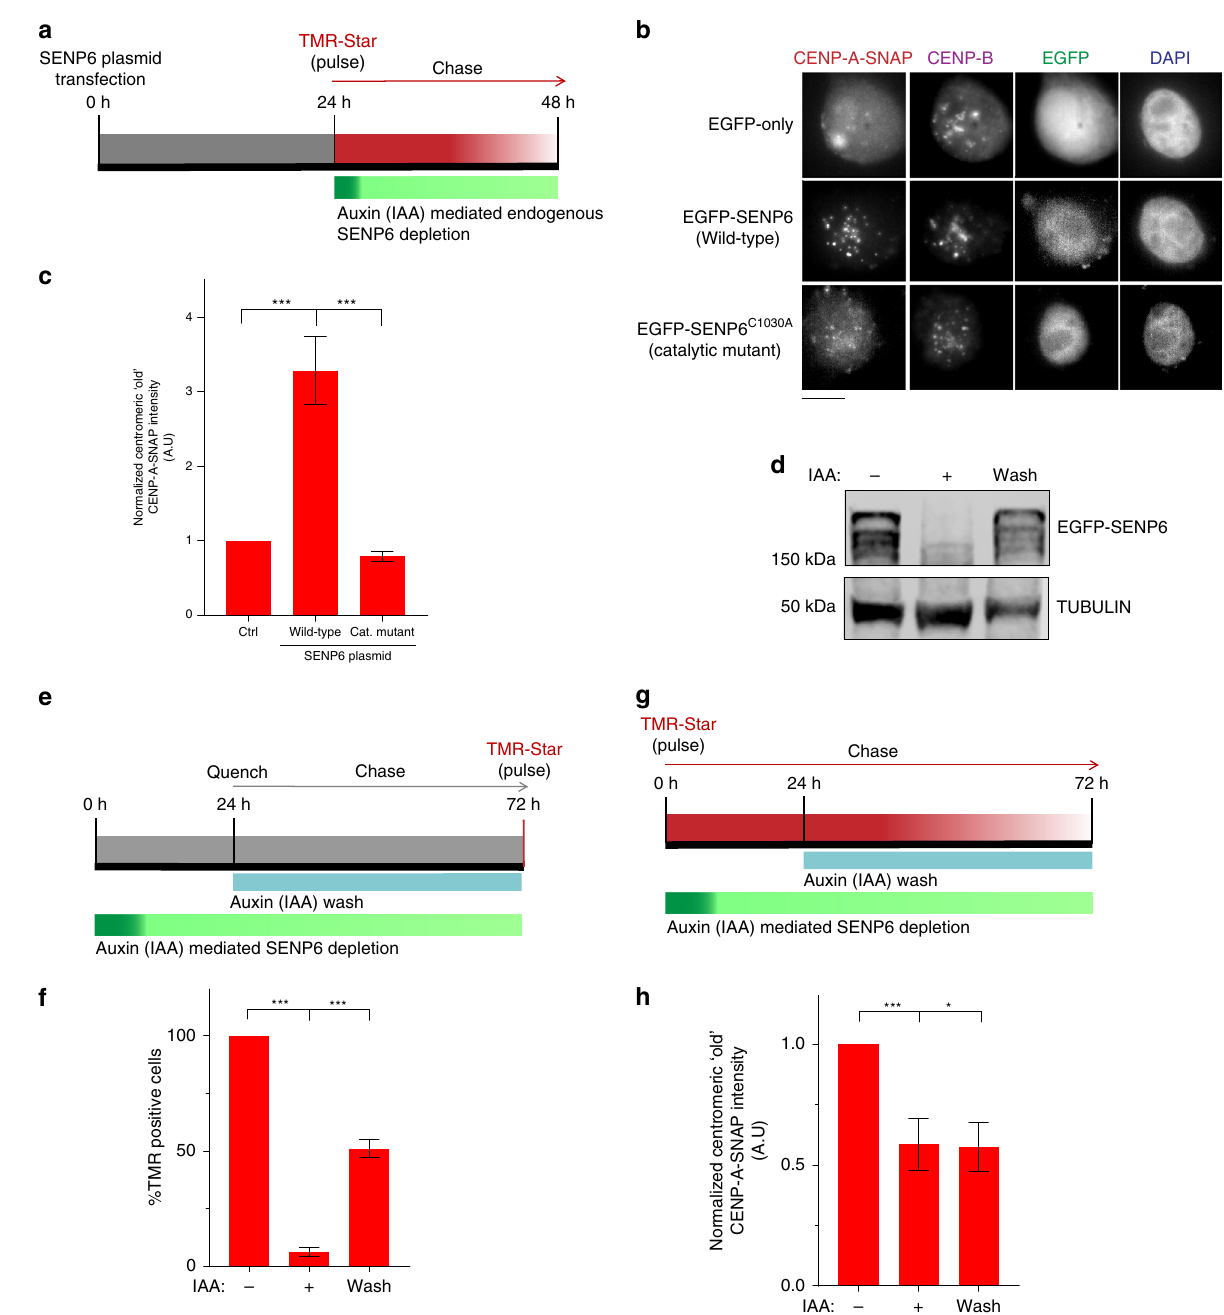
Fig. 4 CENP-A maintenance requires SENP6 catalytic activity. a Experimental scheme coupling overexpression of wild-type or catalytic mutant SENP6 to auxin mediated depletion of SENP6 and tracking the ‘ old ’ CENP-A-SNAP by pulse-chase (PC) assay. b Images of remaining pre-incorporated CENP-A- SNAP signal following auxin mediated depletion of endogenous SENP6 and over-expression of EGFP only (Ctrl), wild-type SENP6 or catalytically dead SENP6 C1030A . Bars, 10 µ m. c Quanti fi cation of the experiment as outlined in a . ‘ Old ’ centromeric CENP-A-SNAP intensities were normalized to the mean of the control condition (Ctrl). Three replicate experiments were performed. Bars represent SEM. Parametric two-tailed Student ’ s t test was performed to calculate statistical signi fi cance. *** p < 0.001. d Immunoblot showing the levels of AID-SENP6 by auxin treatment (24 h) and re-expression following auxin wash for 48 h. e , g Experimental schemes coupling auxin mediated depletion and re-expression of SENP6 by auxin wash to pulse-chase and quench-chase- pulse assay for tracking pre-maintained CENP-A or newly loaded CENP-A. f , h Quanti fi cation of the above. Three replicate experiments were performed. Bars represent SEM. Parametric two-tailed Student ’ s t test was performed to calculate statistical signi fi cance. * p < 0.05, *** p < 0.001. Source data are provided as a Source Data fi